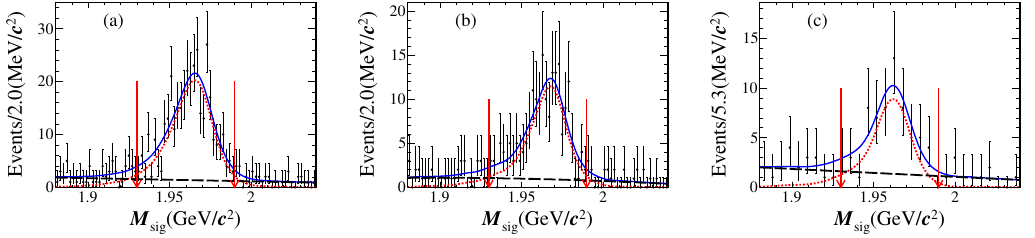
√ s = (a) 4.178 GeV, (b) 4.189–